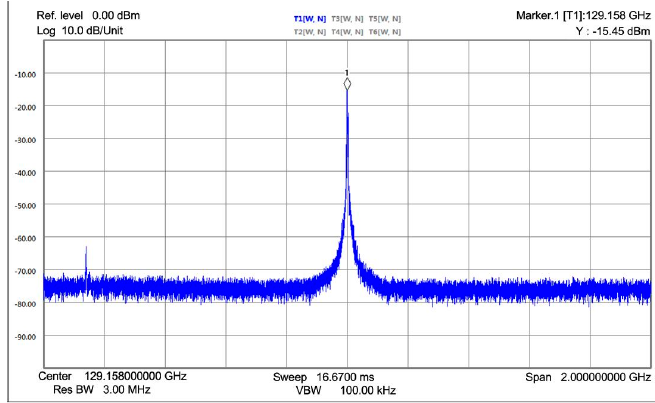
Figure 13. The spectrum of the proposed VCO.